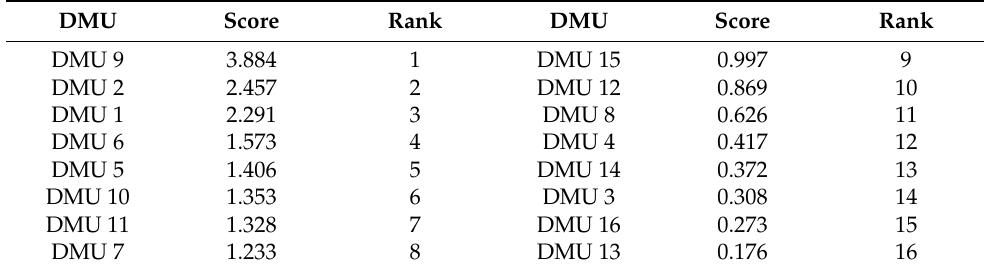
Table 10. Rankings and scores before alliances.